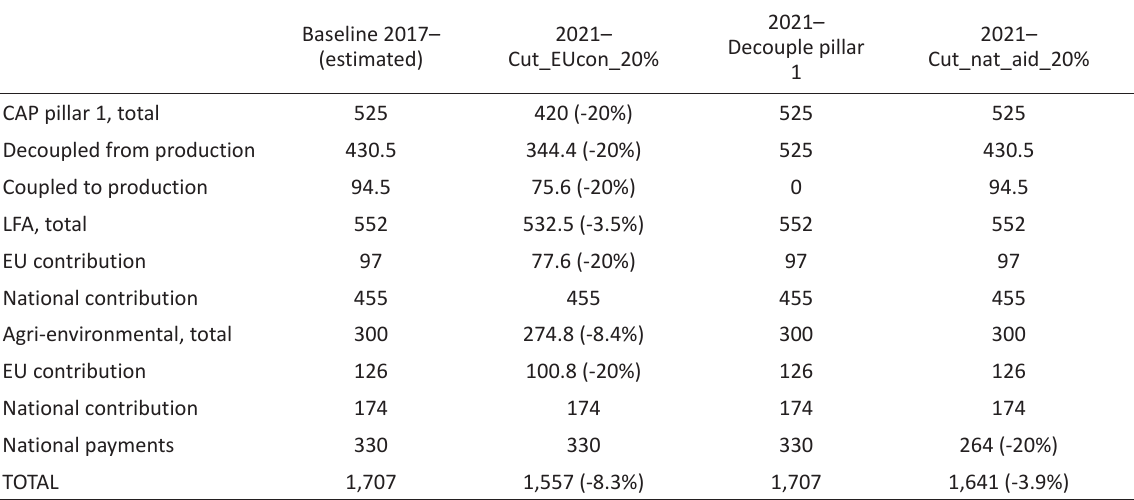
Table 1. Changed EU contributions and total financing (€ million) in pillar 1 and pillar 2 farm support payments in scenarios: 1) A reduction in the EU contribution to agricultural support payments by 20% (Cut_EUcon_20%), 2) CAP pillar 1 payments decoupled from production (Decouple pillar1), 3) A reduction of national payments by 20%